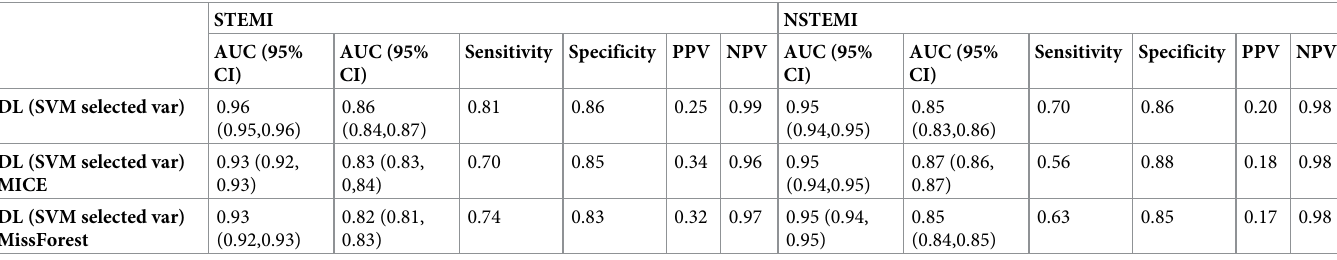
(Table 7). Common features between TIMI risk score for STEMI and NSTEMI and the fea- tures from the best model are age, heart rate, Killip Class, fasting blood sugar and angina. Fig 4 depicts the SHAP summary plot of the SVM (varImp-SBE-SVM) predictors that were combined with DL to achieve the highest performance accuracy. The y-axis indicates the variable name in descending order of importance, with Killip class having the highest importance. On the x-axis is the SHAP value. The gradient colour indicates the variable’s initial value. In Booleans, it can contain only two colours, but in numbers, it can contain the entire colour spectrum. Each point corresponds to a row in the initial dataset. Having a high Killip class, heart rate, age, and fasting blood glucose is associated with high and negative values on the outcome, as observed. Where high is determined by the colour and negative by the x-value. In other words, as the Killip class, age, fasting blood glucose (FBG), and heart rate increase, so does the mortality rate. Meanwhile, cardiac catheterization and medications like oral hypo- glycemic agents, as well as high HDL levels, are linked to survival or a favorable outcome. In the acute setting, such as ACS, LDL-C appears to have a more neutral effect, with high values contributing to similar outcomes. The SHAP force plot in Fig 5 illustrate explanation of the DL for one single observation. The binary goal is either survival (survival = 1) or non-survival (non-survival = 0). The bold Table 6. Detailed performance metrics of best DL model on an imputed dataset for STEMI and NSTEMI patients. STEMI